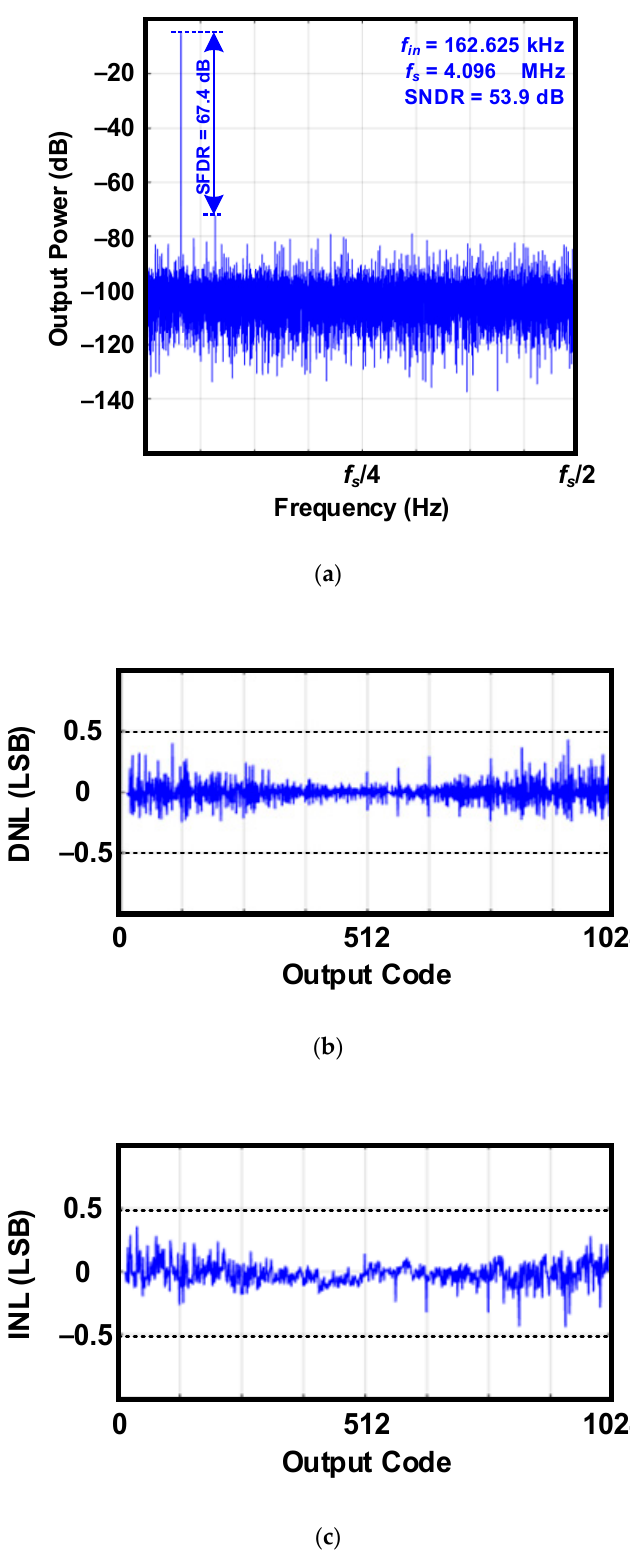
Figure 8. Measured performances of the 10 bit successive approximation register (SAR) ADC: ( a ) Measured output spectrum of digital outputs; ( b ) Measured differential nonlinearity (DNL); ( c ) Measured integral nonlinearity (INL).